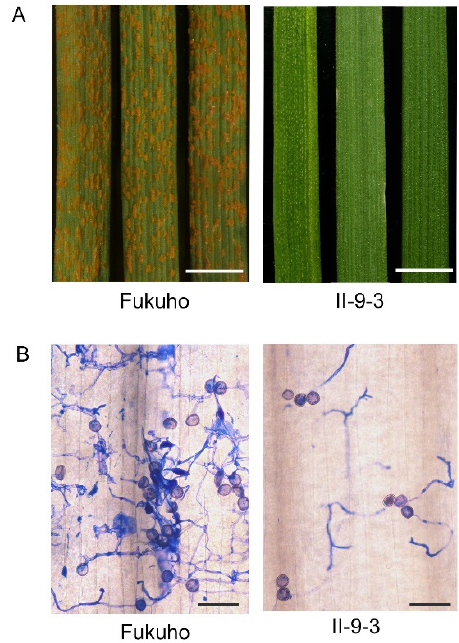
Figure 2. Response of wheat– A. cristatum 2P addition line II-9-3 and susceptible Fukuho to P. triticina race THT: ( A ) disease symptoms of leaves at 10 days after inoculation with P. triticina race THT (bar = 5 mm); ( B ) Coomassie brilliant blue staining of the leaves at 72 h post-inoculation (hpi) with THT to visualize spores (bar = 100 μ m).